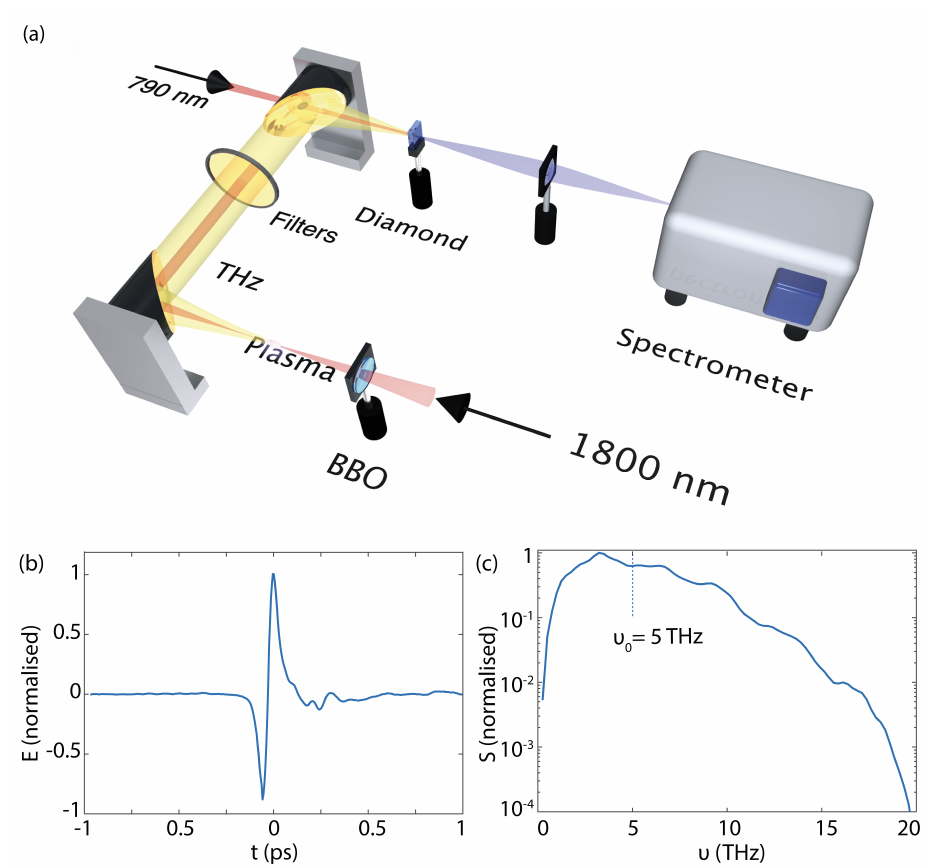
Figure 1. ( a ) Experimental setup. A broadband (20 THz) seed pulse is generated by field ionisation of nitrogen in an asymmetric field composed of 1800 nm and 900 nm radiation. The THz electric field recorded via air-biased coherent detection (ABCD) and its spectrum are shown in ( b , c ), respectively. The THz field is collimated by a gold-coated off-axis parabolic mirror and filtered by two gold mesh long pass filters in order to remove every frequency component above 20 THz. The THz pulse is then focused in a diamond single crystal sample collinearly, and is temporally overlapped with an intense 790 nm pump pulse. The generated UV radiation is collected by a lens and detected by an imaging spectrometer coupled to a charge-coupled device